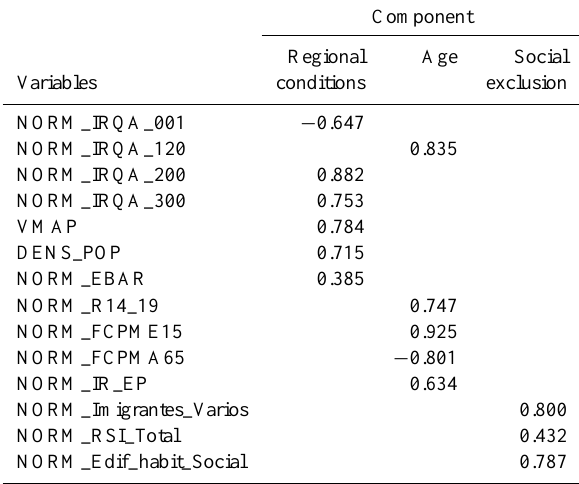
Table 5. Final components and their corresponding variable load- ings. The name given to each component was based on the interpre- tation of the flood social susceptibility characterization given by the variable group that composes